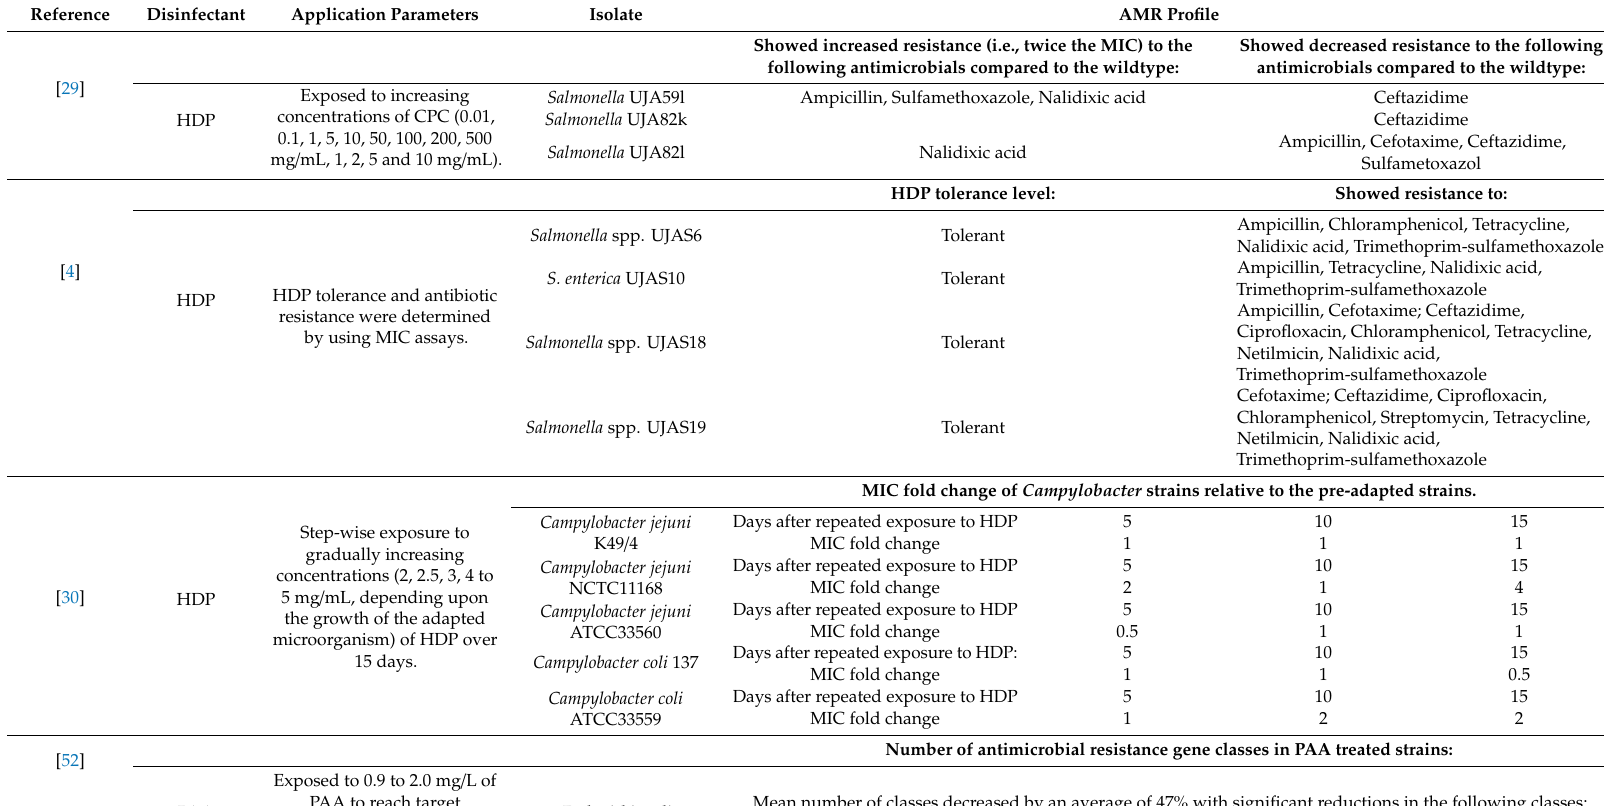
Table 2. AMR profiles of isolates challenged with disinfectants commonly used during poultry